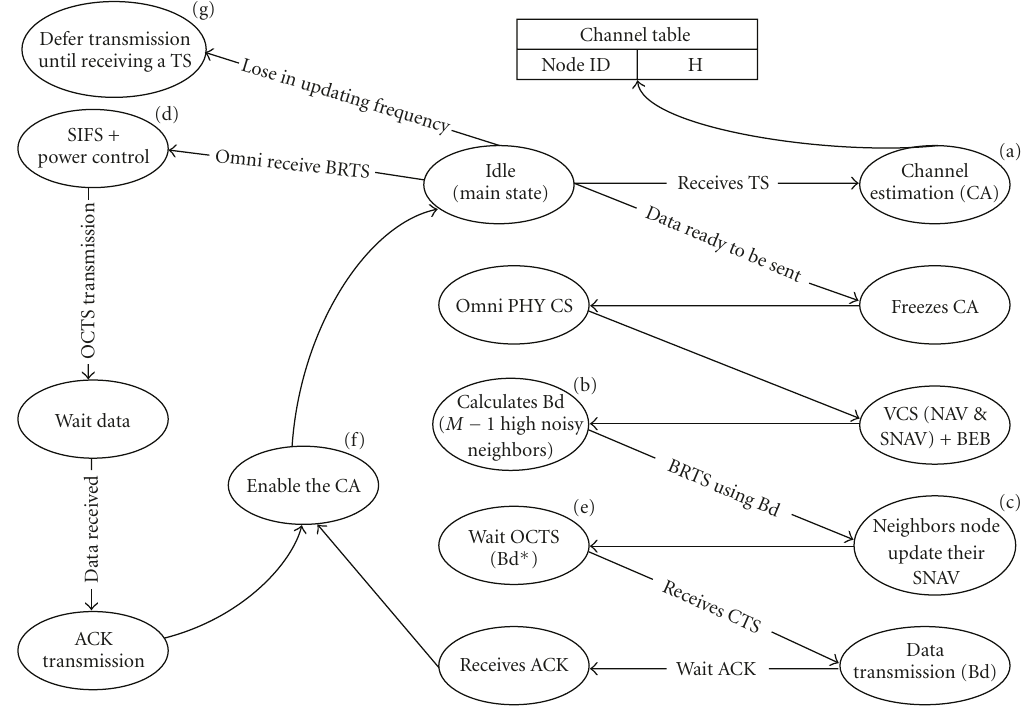
Figure 1: Simplified state diagram of the